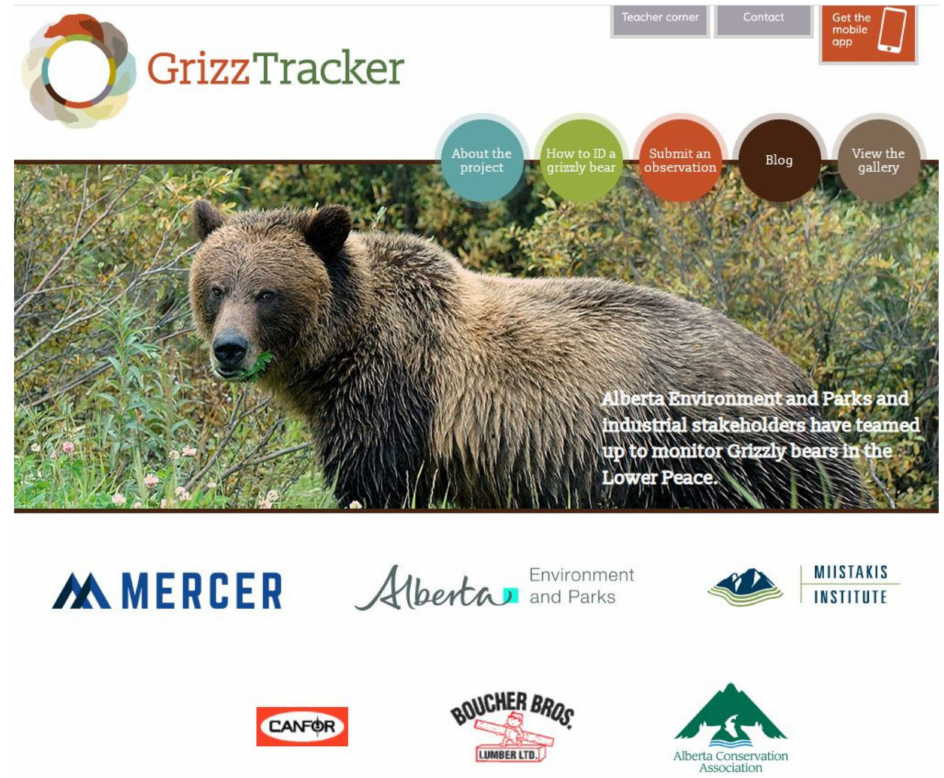
Figure 2. GrizzTracker website landing page (grizztracker.ca, accessed on 20 December